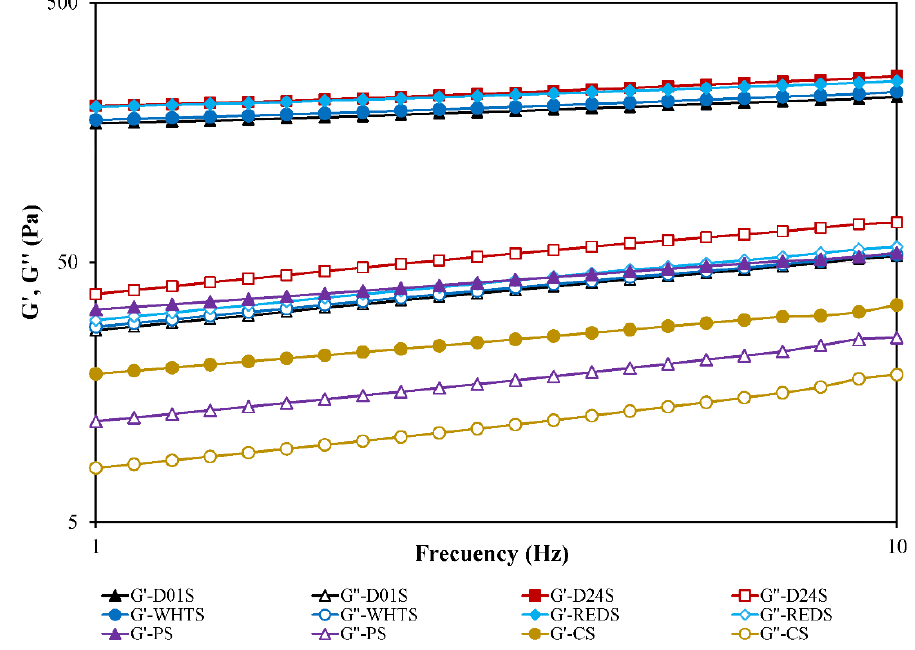
Figure 5. The mechanical spectra curve of anchote starch gels (D01S = Desta 01 starch, D24S = Desta 24 starch, WHTS = white starch, REDS = red starch), potato starch (PS), and cassava starch (CS) obtained from frequency sweep tests (G′ and G″ versus frequency). G′ is represented using solid symbols, and G″ with open symbols.